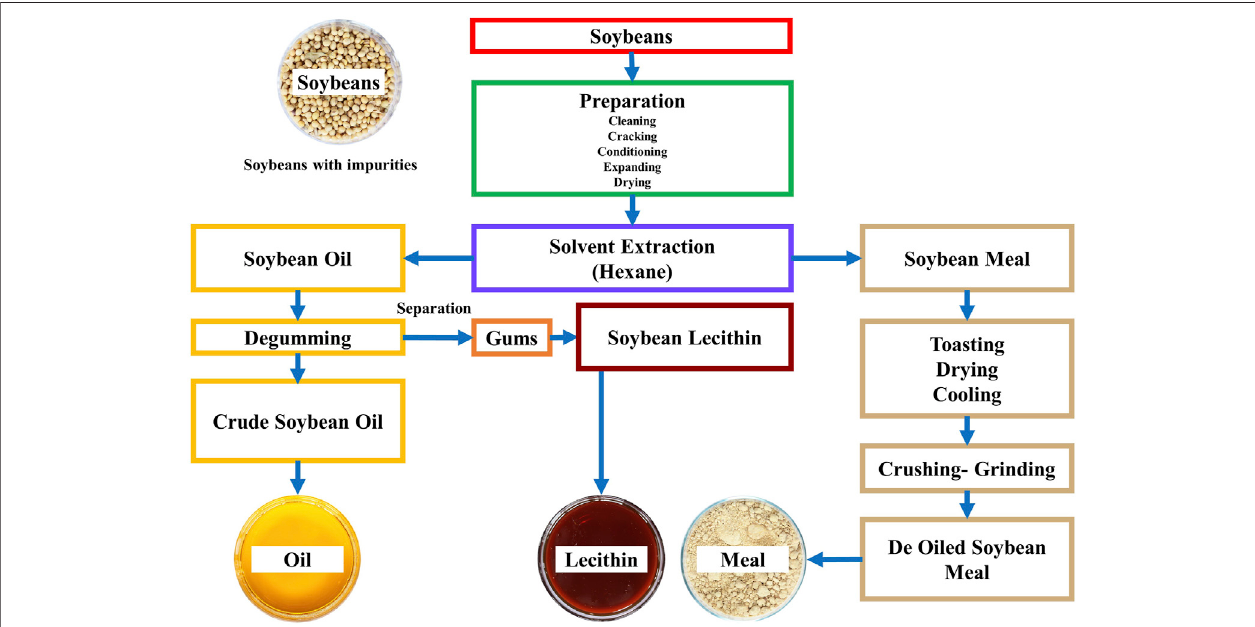
FIGURE 1 | Soybean processing fl ow to produce oil, meal and